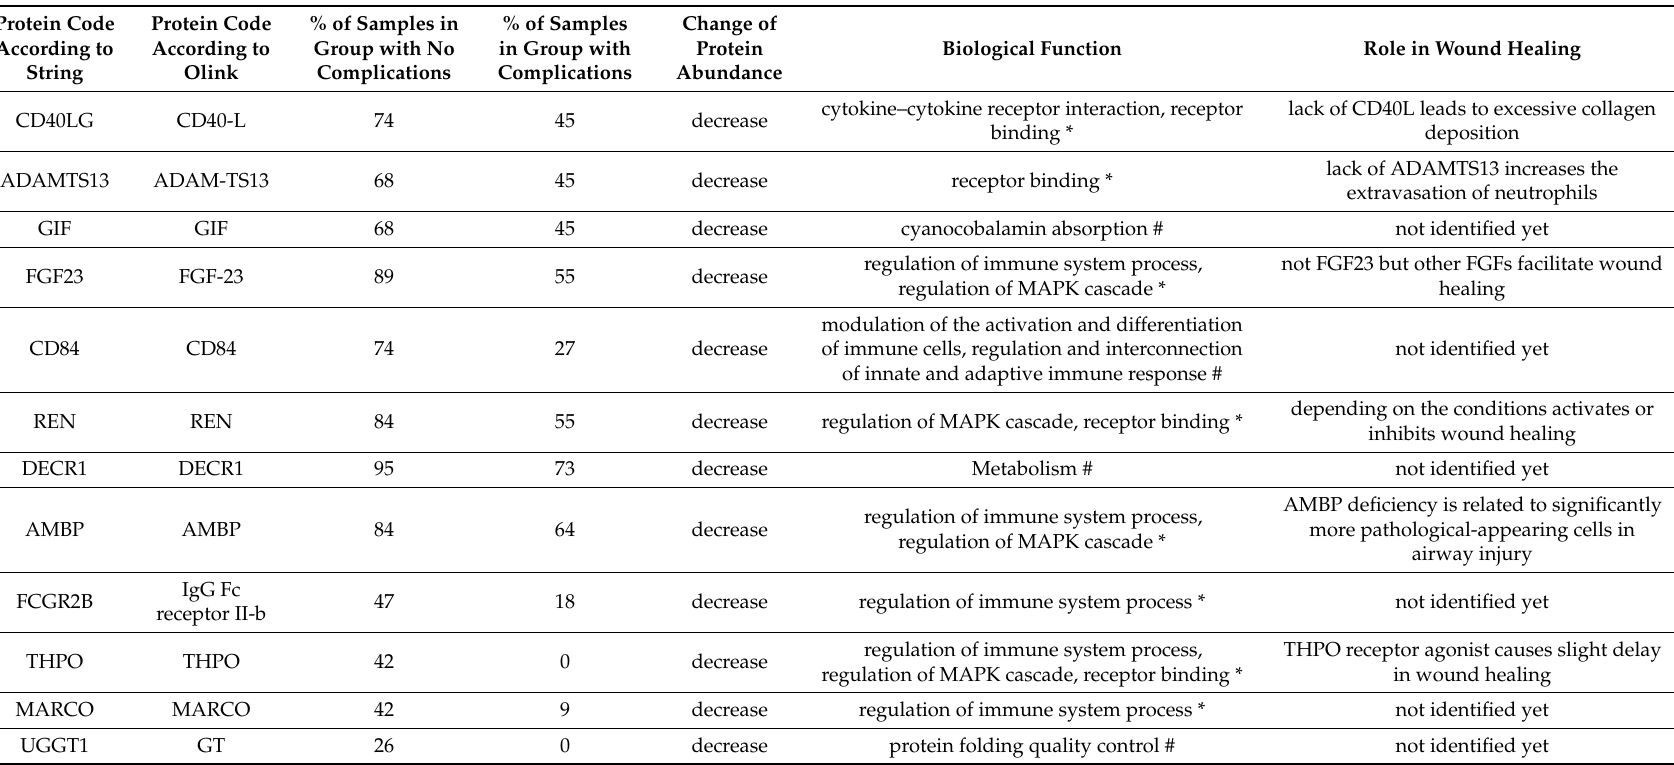
Table 1. List of proteins with altered abundance in the group with complications. The percent of samples expressing the indicated protein in the group with and without complications is listed in the case of each protein where the difference was more than 20% between the two groups. The direction of change in the group with complication is indicated along with biological function and the role in wound healing in the case of each protein. * indicates the enriched Gene Ontology (GO) function calculated by String, and # indicates function as listed in String. ADAMST13: A disintegrin and metallopeptidase with thrombospondin type 1 motif